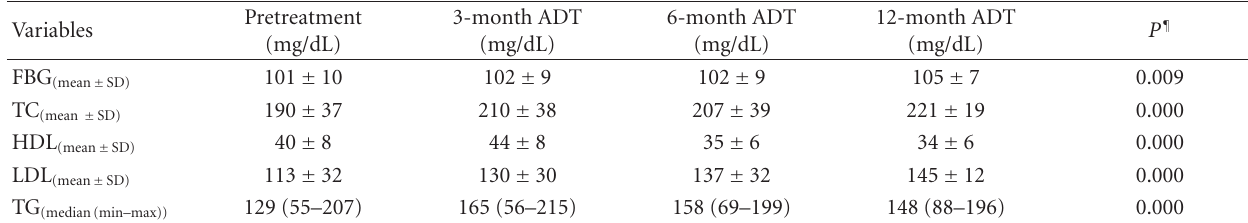
Table 1: Pretreatment and one-year treatment values of FBG levels and lipid profiles.